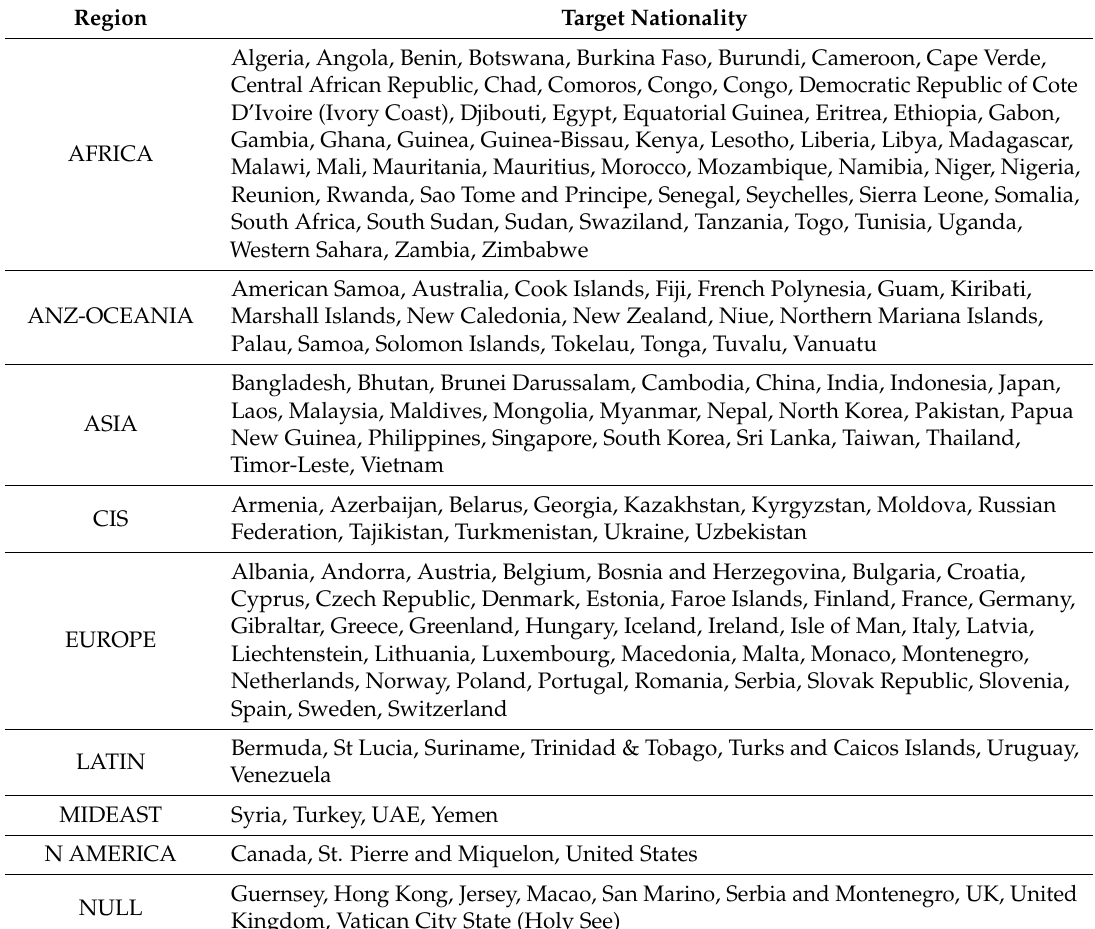
Table A4. Definitions for